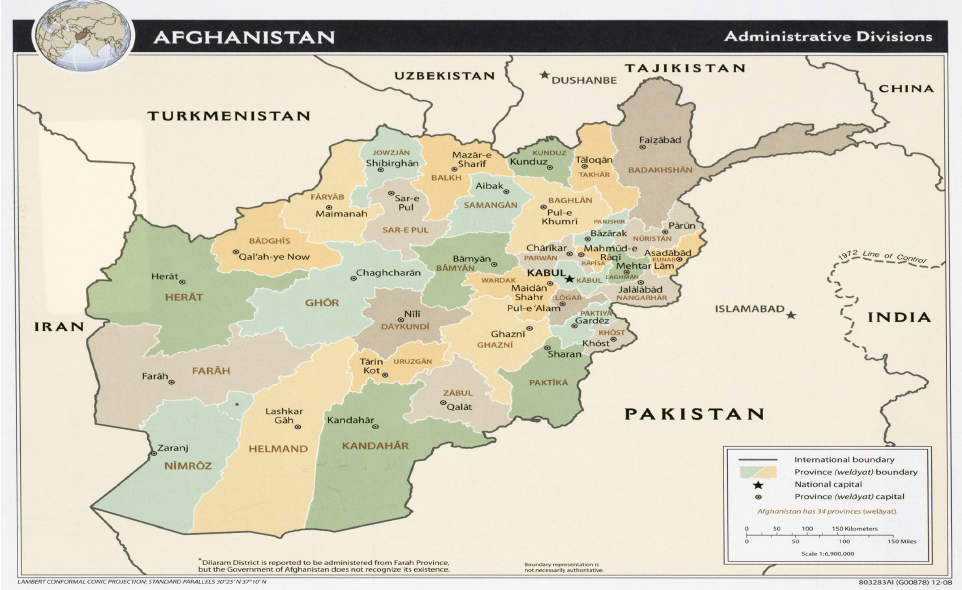
Figure 1. Map of Afghanistan